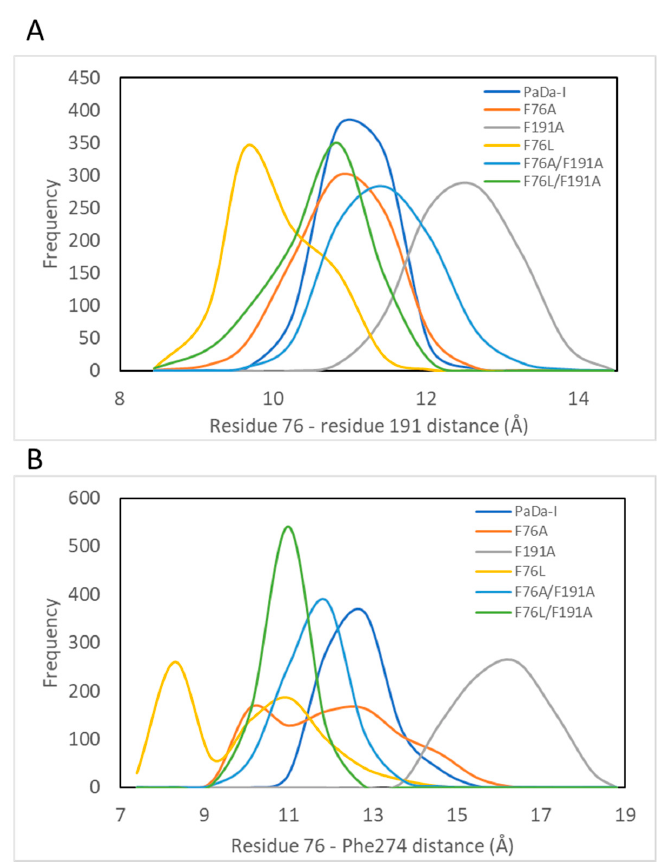
Figure 5. Frequency distribution of distances from residue number 76 to 191 (panel A ) and from residues 76 to 274 (panel B ). The distance was measured between the two alpha carbons during the last 40 ns of the MD simulation. Int. J. Mol. Sci. 2020 , 21 , x FOR PEER REVIEW